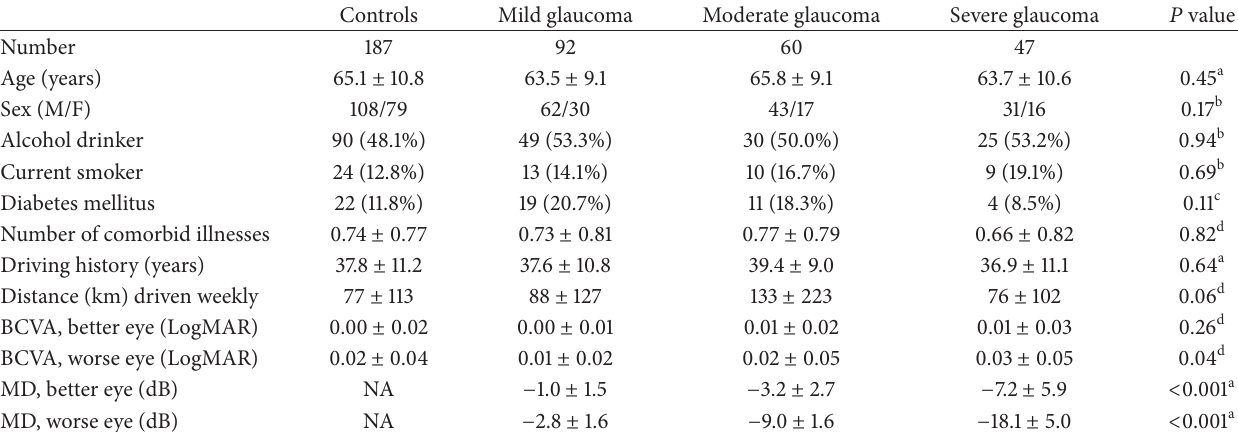
Table 1: Demographic characteristics grouped by MD in the worse